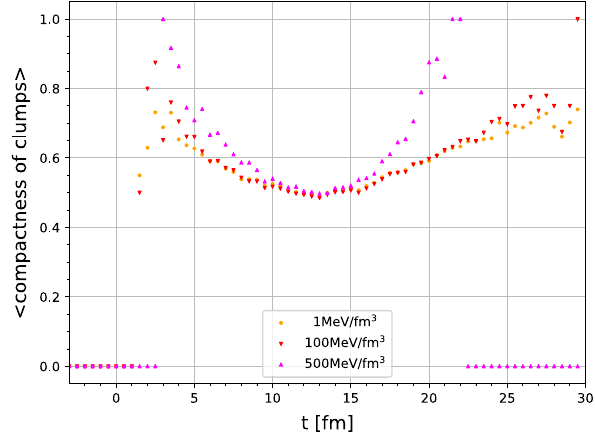
Fig. 22 Time evolution of the average compactness of the connected regions (clumps) satisfying the constraints X ebe < 0 . 3 and Y ebe < 0 . 3 fortheenergydensitythresholds ε > 1,100or500MeV / fm 3 ,inAu+Au collisions at E lab = 1.23 AGeV, 0–5% centrality